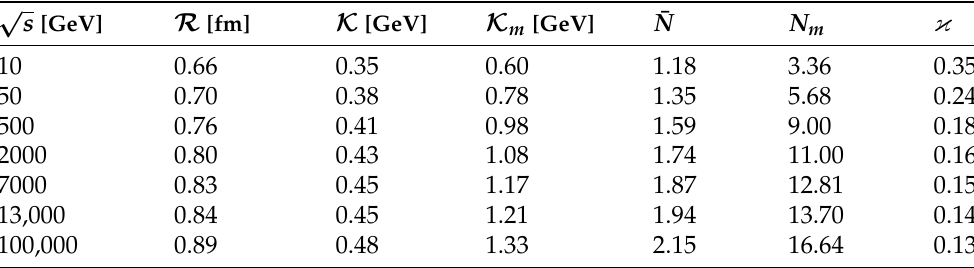
Table 1. Estimated parameters in the mode of uncorrelated motion of the partons: the effective transverse radius of the nucleon R ; transverse RMS momenta of the peripheral partons, average K and maximum K m in cascades; the number of the partons in cascades, average ¯ N and maximum N m ; cascade saturation parameter κ